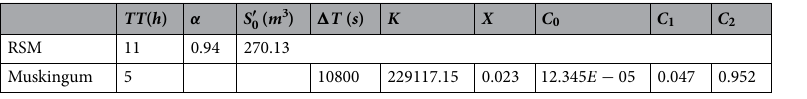
Table 3. Parameter of the calibration results for the Wilson event.